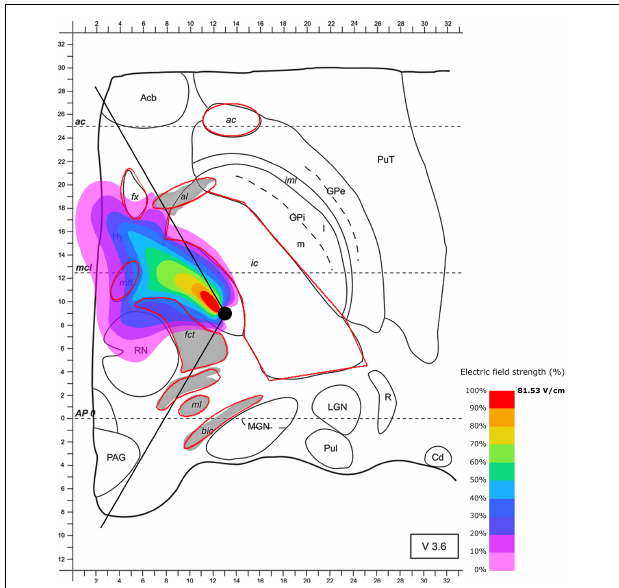
FIGURE 3 | Simulation of the electric field generated by segmented electrode stimulation through one active pole (130 Hz, 60 µ s and 2/3 mA) with the electrode lead positioned in the STN. Positioning of the electrode’s active pole according to Pollo et al. (2014) (medial direction of the active pole). Electric field distribution after 60 µ s (maximal field extension); for abbreviations see Figure 1